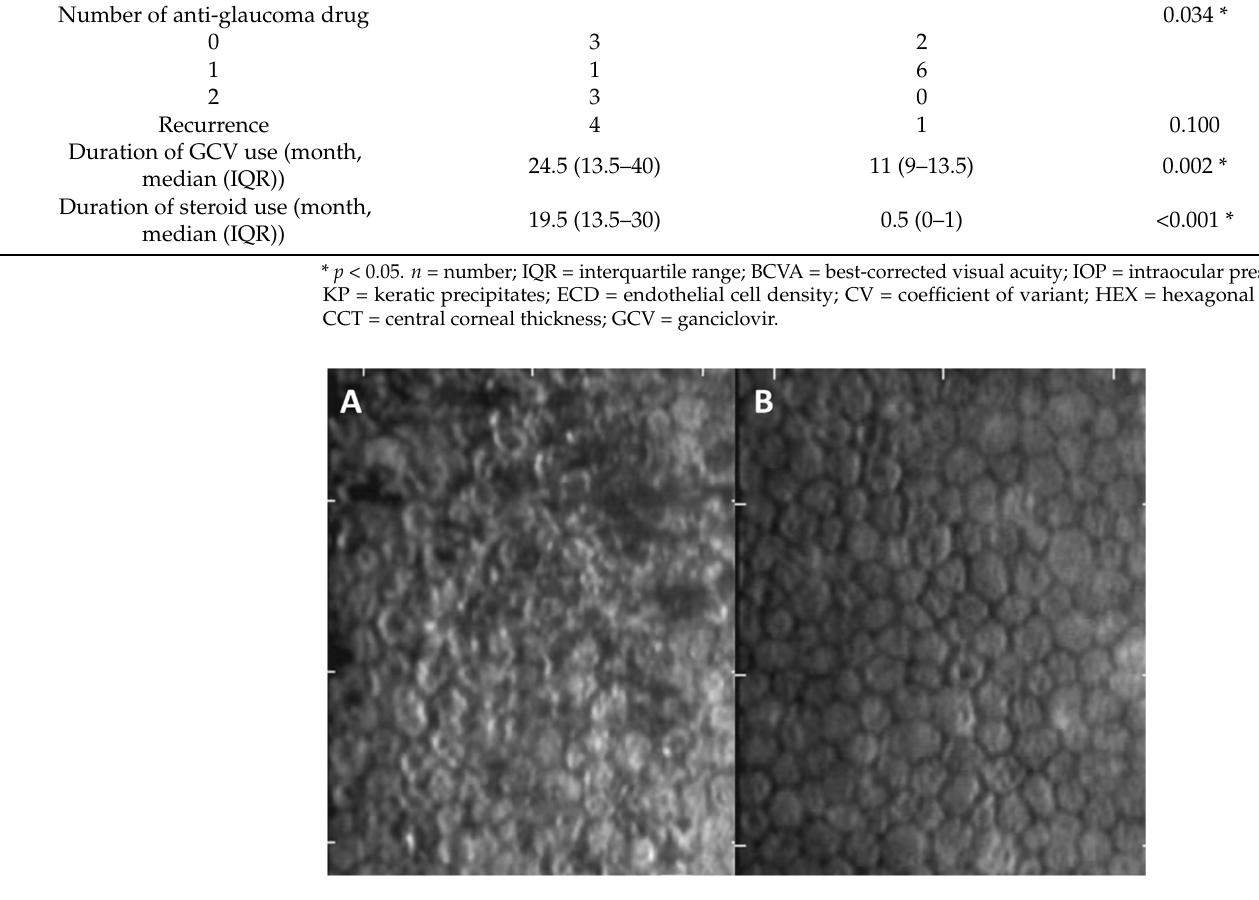
Table 2. The Difference of Initial Clinical Manifestation Between the Steroid Subgroup and Non- steroid Subgroup.